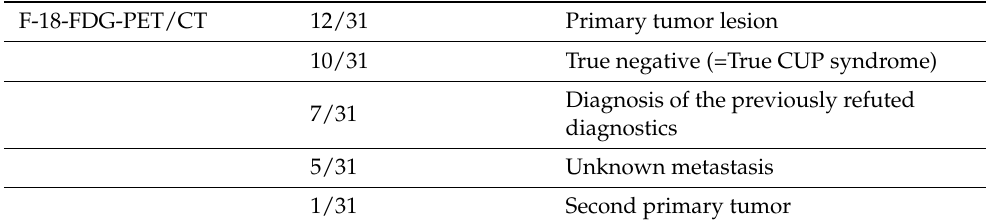
Table 4. Information obtained by